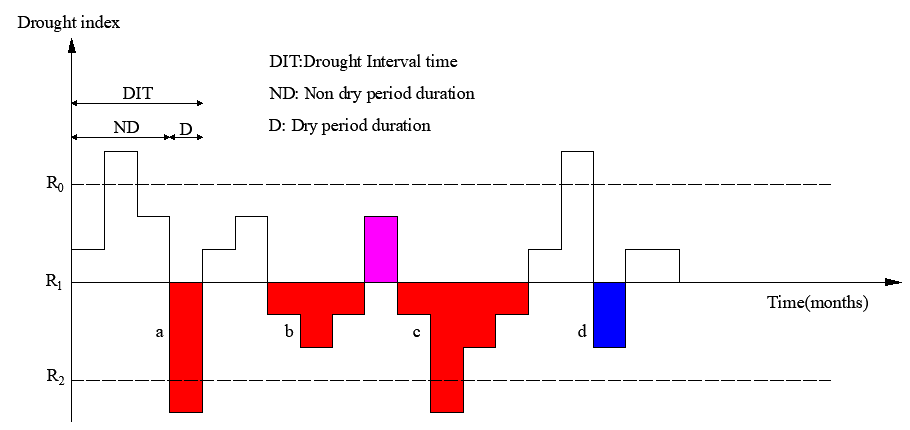
Figure 2. Definition of drought events based on drought index using Theory of Runs.